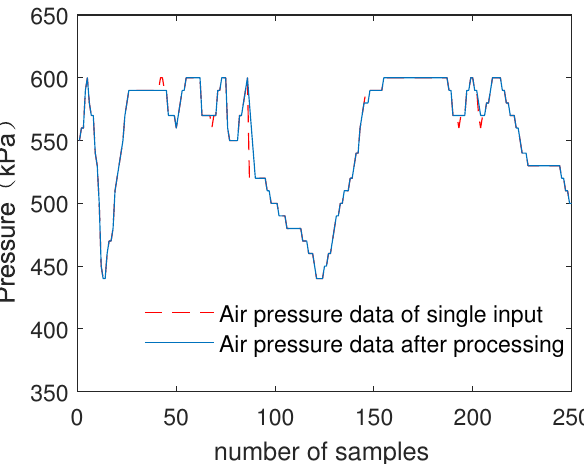
Figure 8. Single input of air pressure data and processed